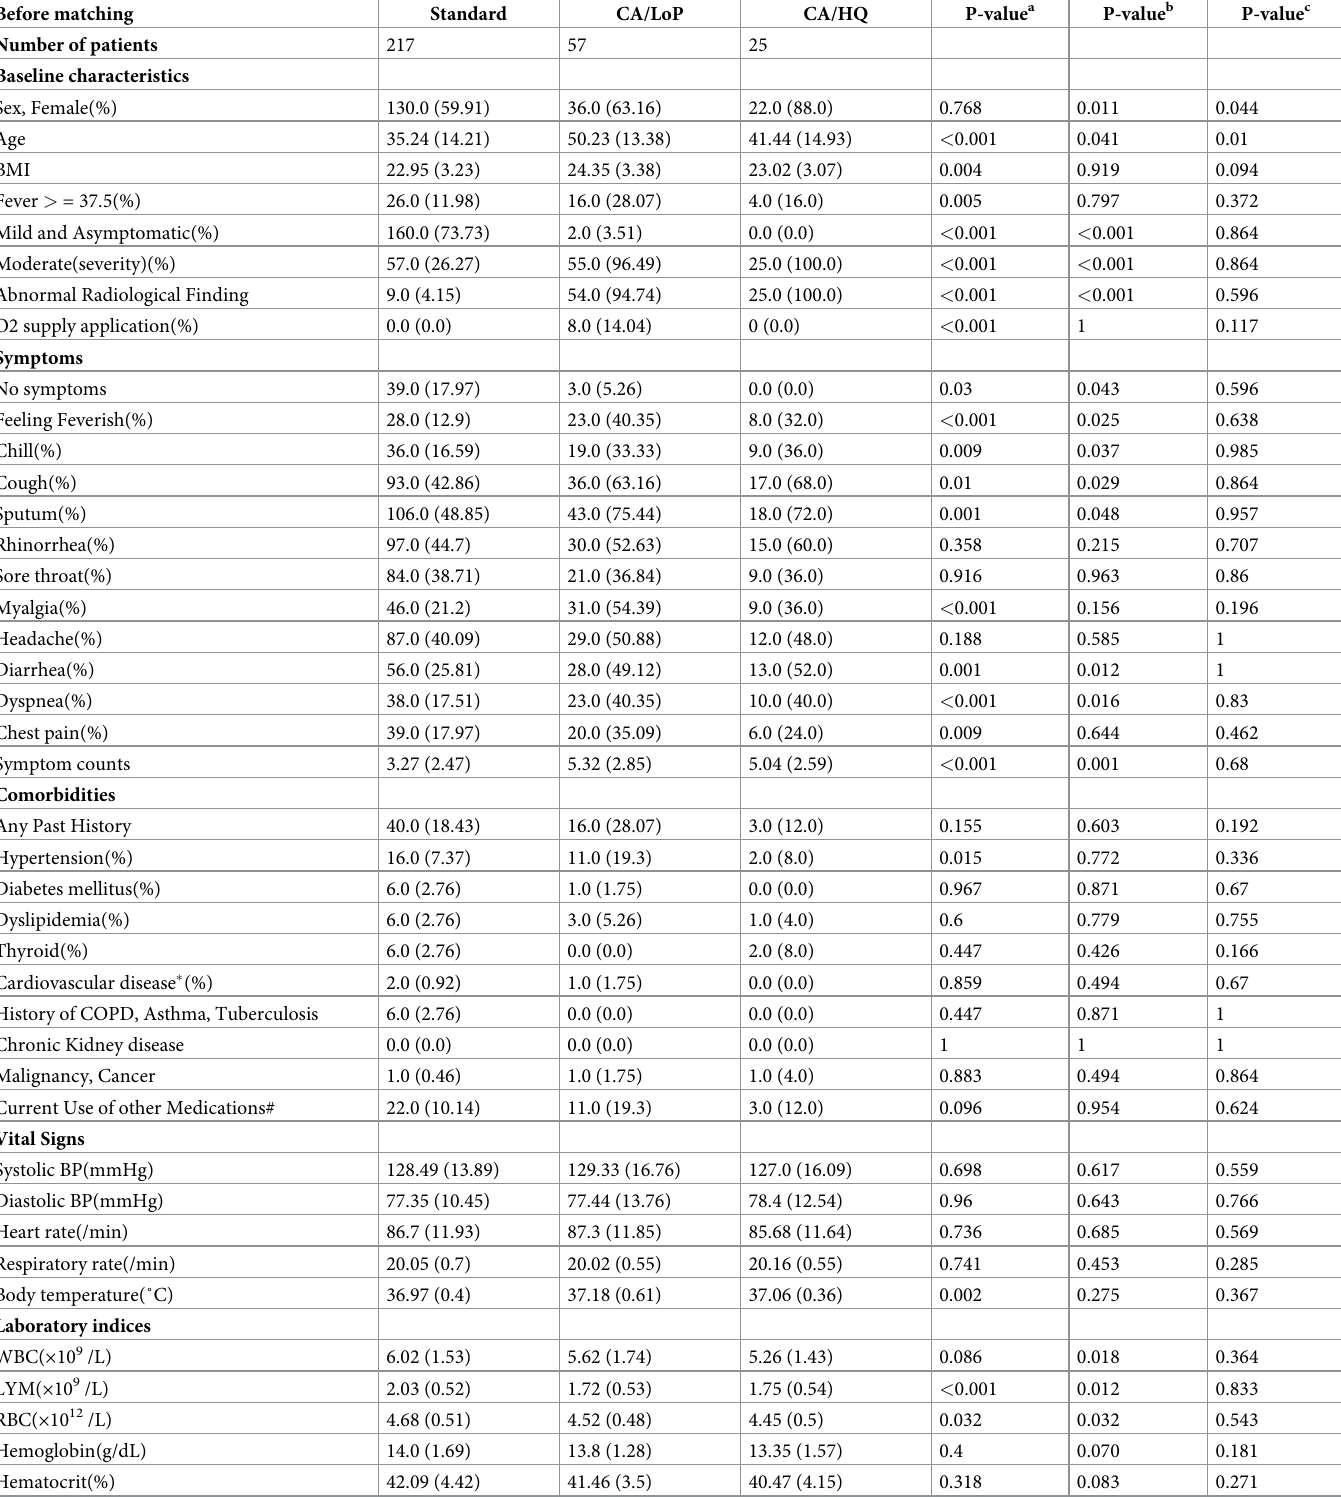
Table 1. Baseline characteristics, symptoms, comorbidities, vital signs, and initial laboratory indices of study cohorts before propensity score